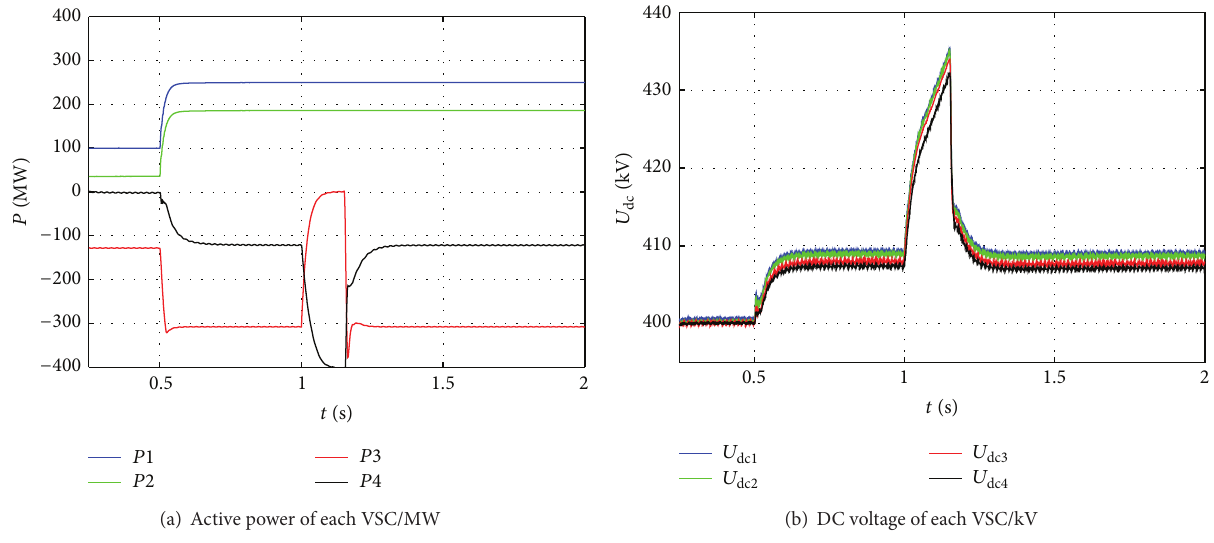
Figure 9: Simulation of three-phase faults of AC